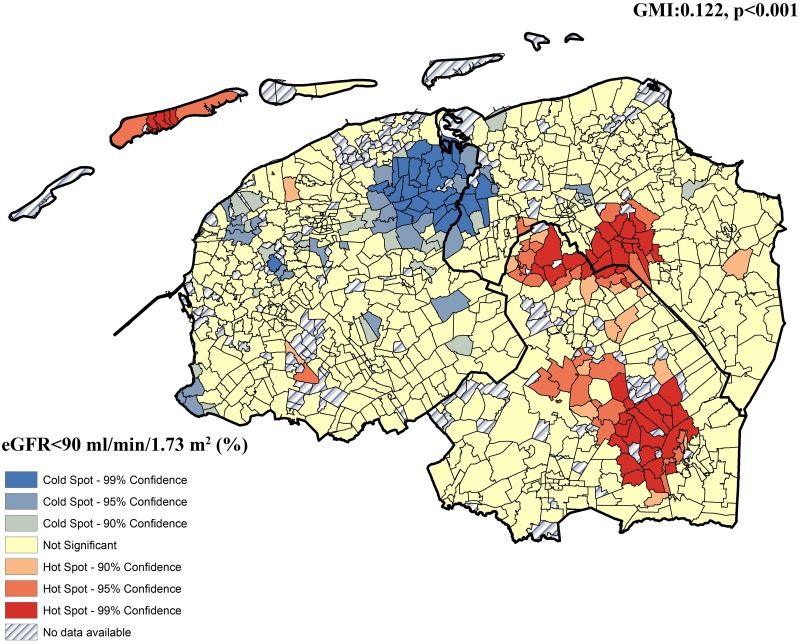
The intraregional distribution of proportion of eGFR<90 ml/min/1.73m2 in Northern Netherlands.Hot spots were shown as red colors and cold spot were shown as blue colors.